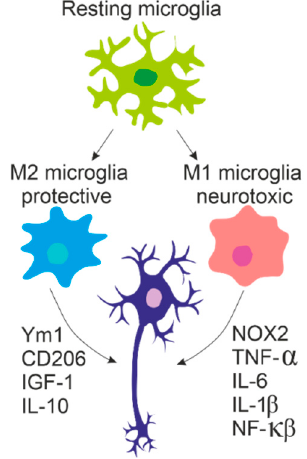
Figure 2. M2 and M1 microglia release certain molecules that are able to influence the survival of MNs. The molecules and their effect depend on the phenotype of microglia. M1 are toxic, while M2 microglia are protective.